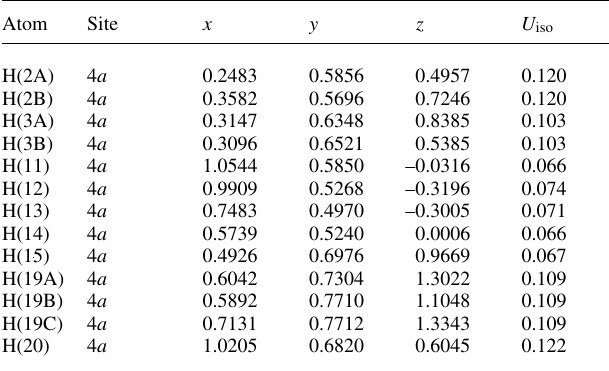
Table 2. Atomic coordinates and displacement parameters (in Å 2 )